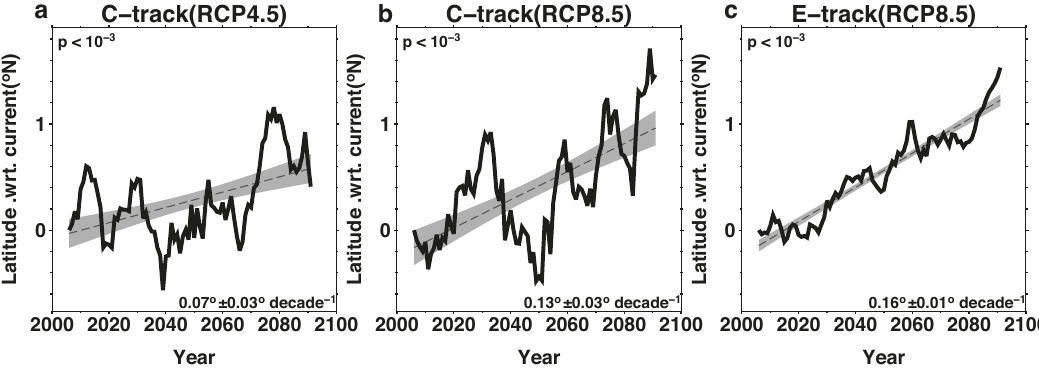
Fig. 1 Latitude time series. MME-averaged latitude time series of the 3 TC track groups, with trends and p -values. 95% con fi dence trend bounds are shaded.